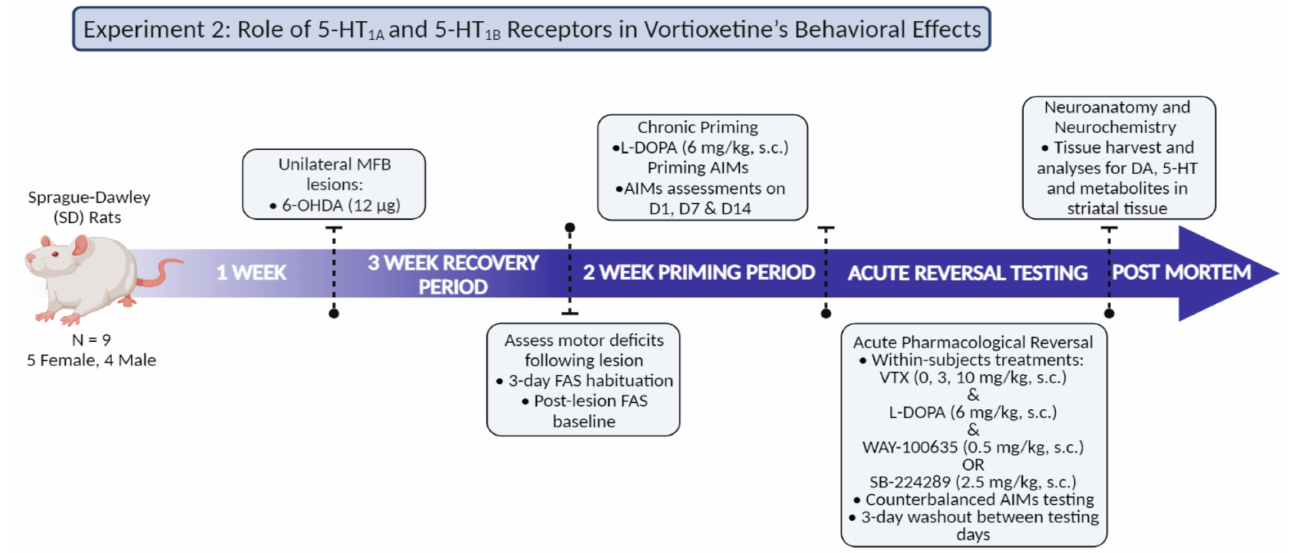
Figure 2. Experimental Design 2: Role of 5-HT 1A and 5-HT 1B Receptors in Vortioxetine’s Behavioral